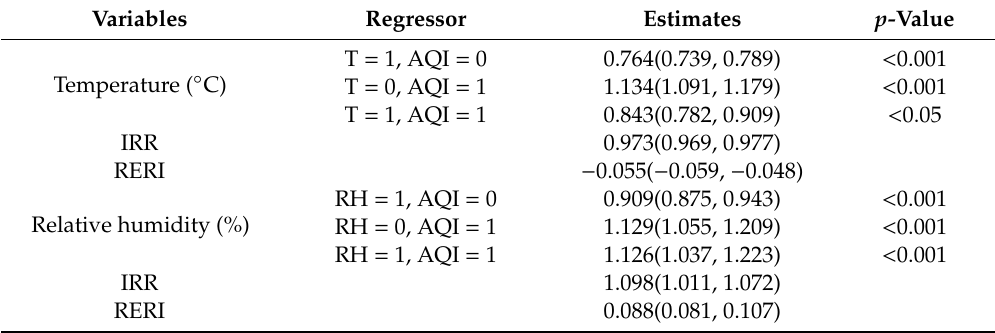
Table 3. Interactive analysis between AQI and climatic factors on circulatory mortality.